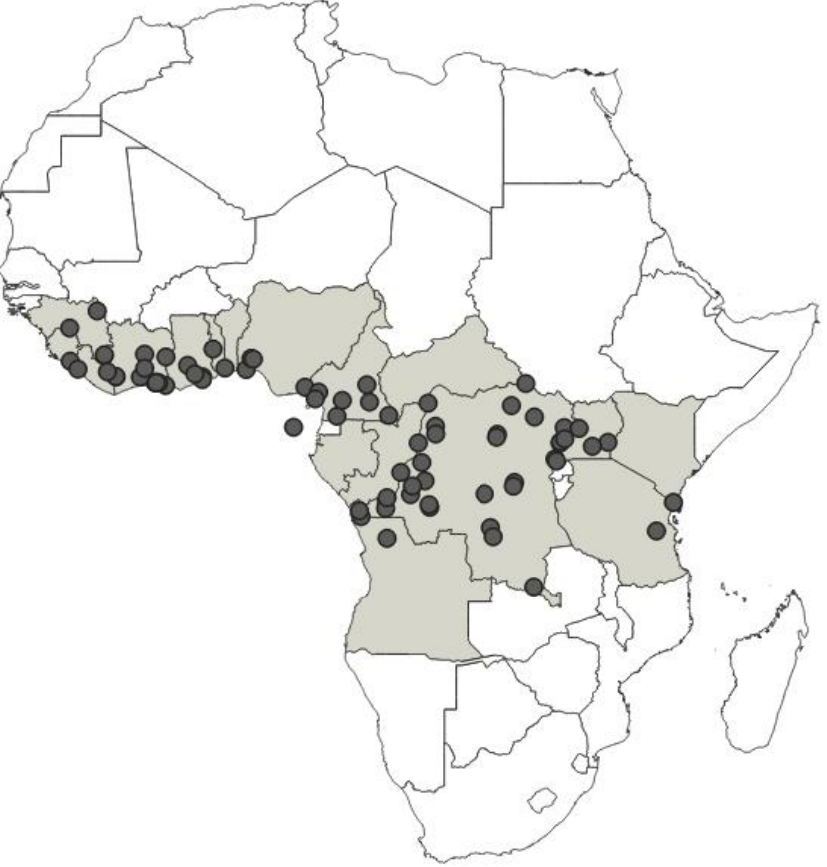
Figure 45. Known distribution of Phonoctonus immitis Stål, 1865.